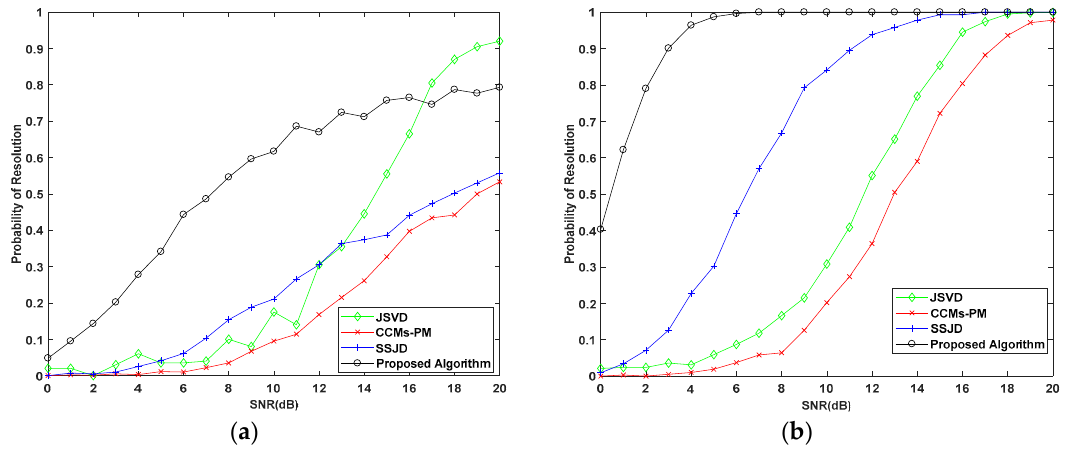
Figure 11. Probability of Resolution versus SNR for a small number of snapshots with ( a ) snapshots = 10; ( b ) snapshots = 20.